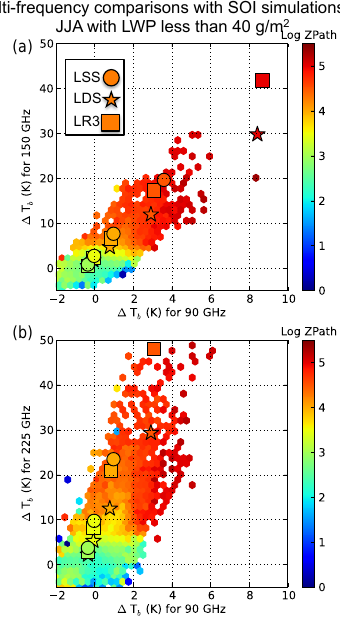
Figure 7. SOI simulated BT differences plotted on top of the obser- vations for the 150 versus 90GHz and 225 versus 90GHz channels ( a and b , respectively). In both examples, the slopes of the simula- tions agree well with the